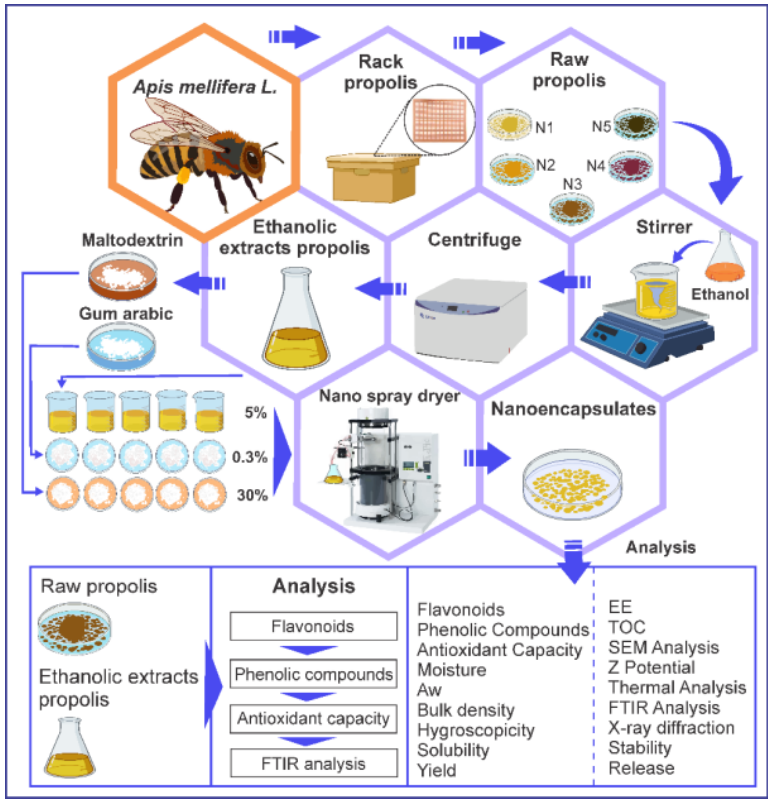
Figure 3. Experimental design for nanoencapsulation.